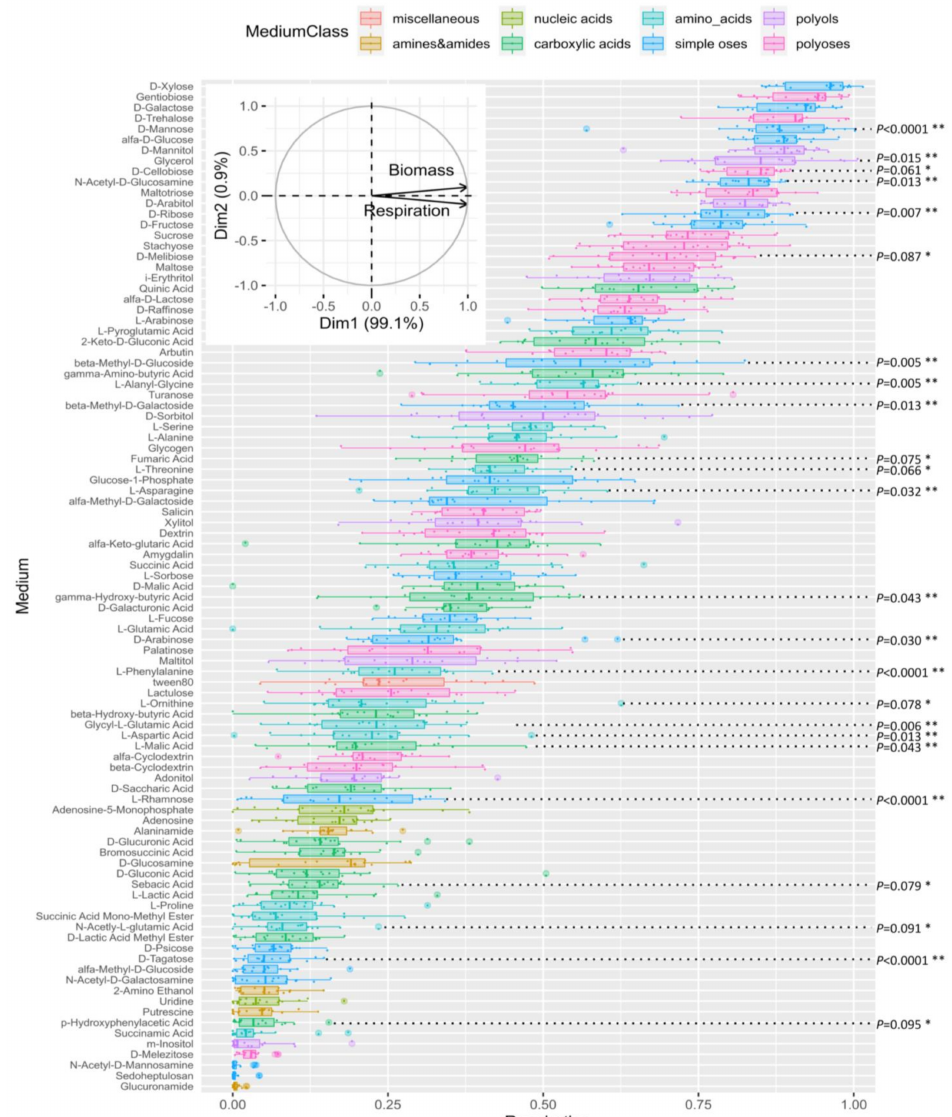
Figure 5. Comparative carbon source utilization profiles of the five ∆ Triat XIP mutants and the T. atroviride parental strain. Strains were grown on 95 carbon sources (FF-plates) using the Biolog Phenotype Microarray system. The order of the organic sources is the rank of respiration rate and substrate use measured at OD490 nm on 95 organic sources and water after 96 h of incubation. Each organic source is colorized according to biochemical class. The mycelial respiration corresponds to the mean of three independent biological experiments per strain, and bars represent the biological standard deviation. ** Respiration rates from the five ∆ Triat XIP that were significantly different from that of the T. atroviride parental strain as verified by t -test ( p < 0.05). * Statistical data not significantly different ( p > 0.05) between the five ∆ Triat XIP mutants and the parental strain, but reflect interesting metabolic trends. Statistical data are detailed for the 95 carbon sources in Figure